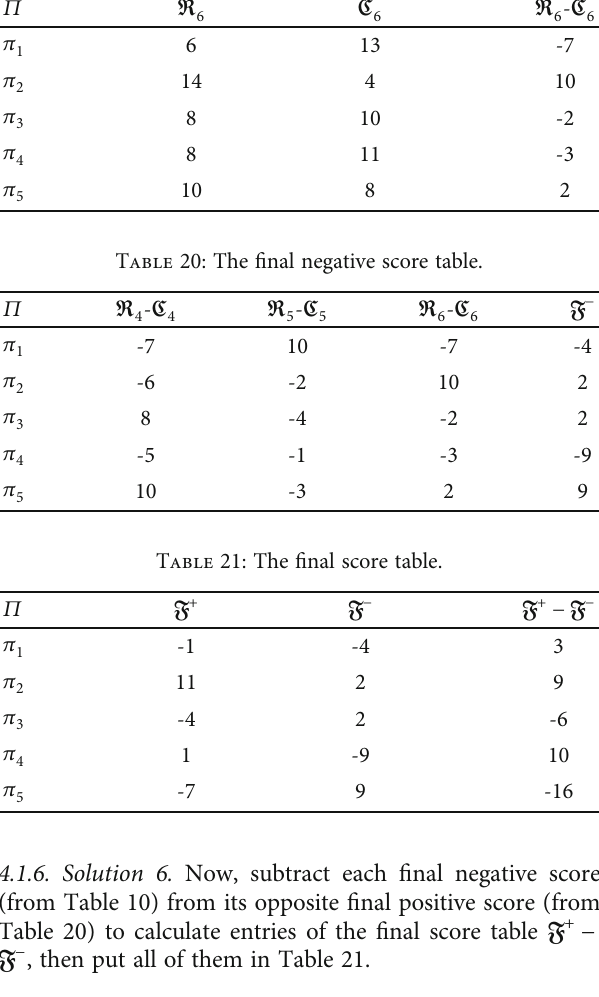
(from Table 10) from its opposite fi nal positive score (from Table 20) to calculate entries of the fi nal score table F + − F − , then put all of them in Table 21.